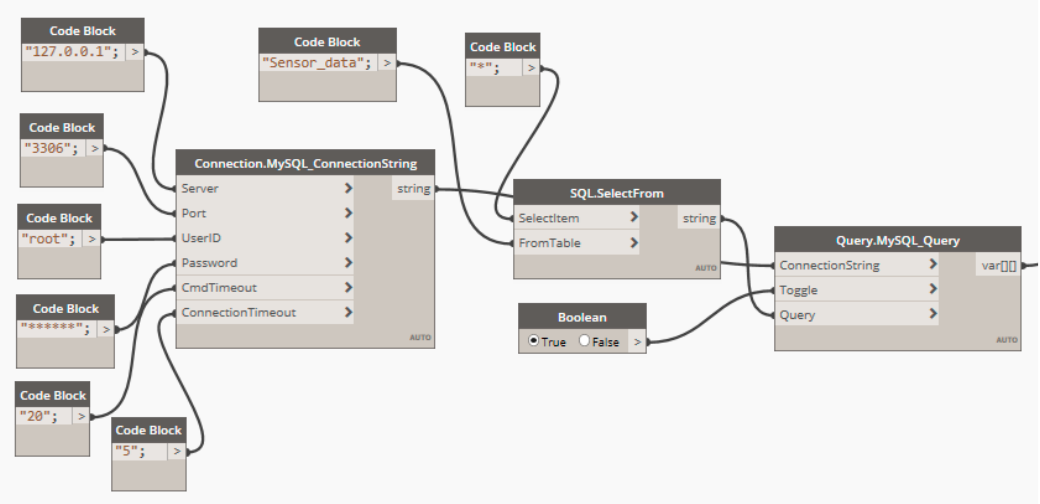
Figure 10. Dynamo nodes of connecting BIM model to MySQL database.